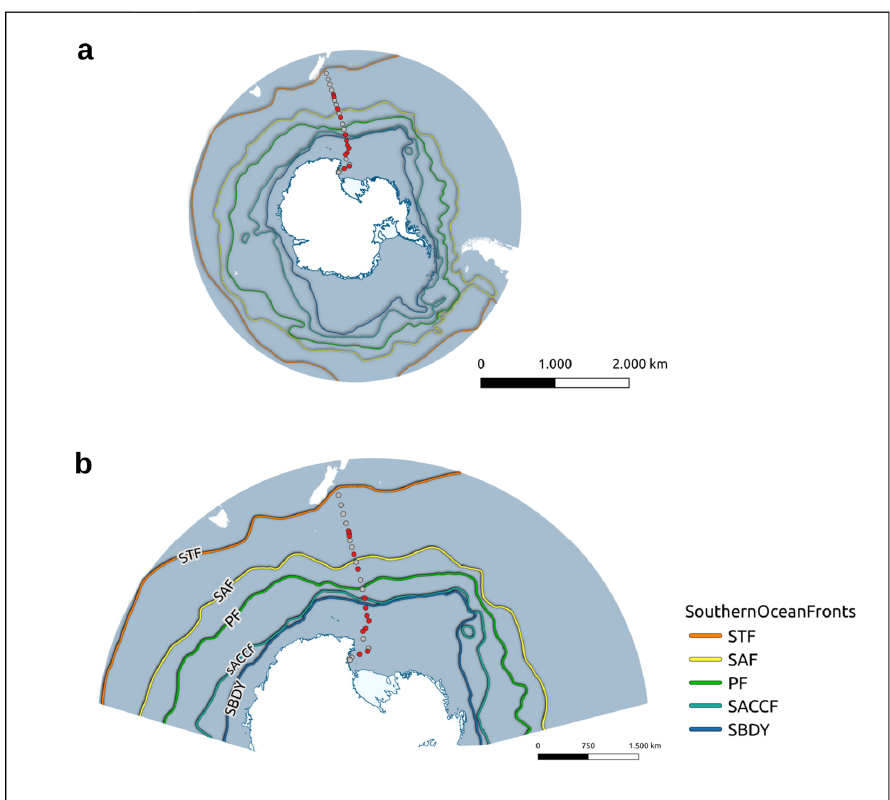
Figure 1. Transect between New Zealand and the Ross Sea sampled during the oceanographic campaign: ( a ) Distribution of the sampled stations (gray dots) and of the stations for which 16S rRNA libraries were obtained (red dots). In the figure are also reported the current fronts crossing the transect: STF—Sub-Tropical front; SAF—Sub-Antarctic Front; PF—Polar Front; SACCF— Southern Antarctic Circumpolar Current front; SBDY—Southern Boundary of the ACC; ( b ) Zoomed view of the stations covered within the transect with their name.